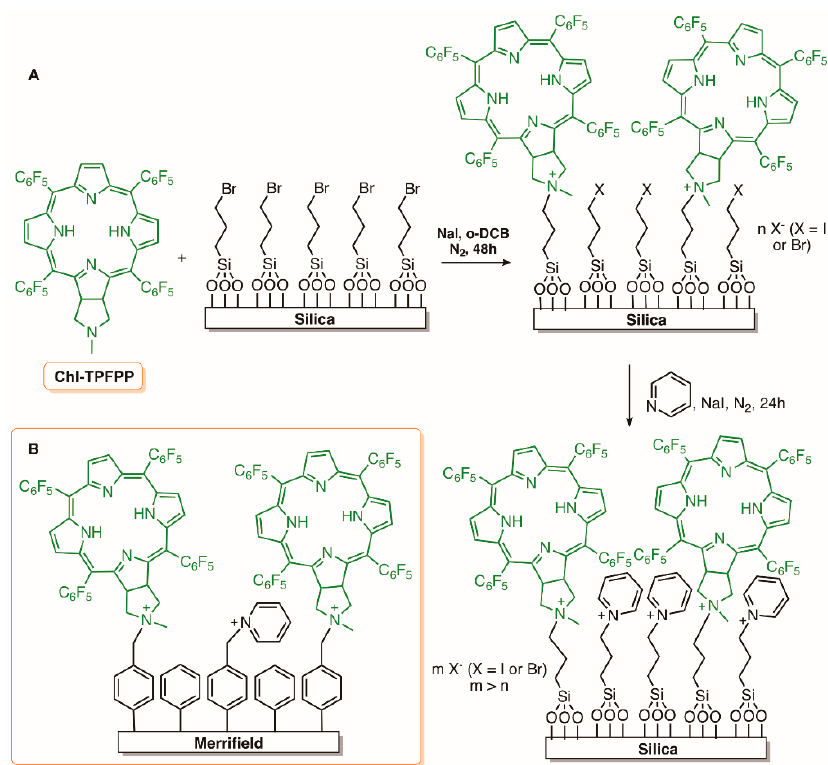
Figure 12. ( A ) Schematic representation of the immobilization of a pyrrolidine-fused chlorin derivative on a modified silica gel support with further cationization with pyridine units. ( B ) Diagram of the pyrrolidine-fused chlorin derivative immobilized on a cationized Merrifield resin (adapted from Reference [101]).